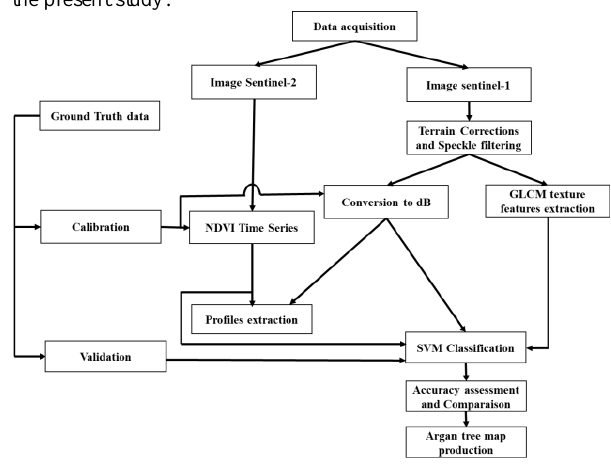
Figure 2. The methodological approach followed in the present work.